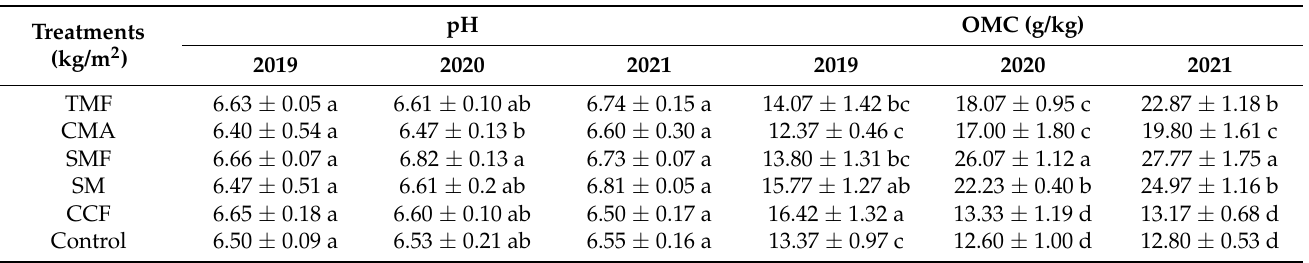
Table 3. Effects of different microbial fertilizers on the pH and organic matter content in newly reclaimed soil.